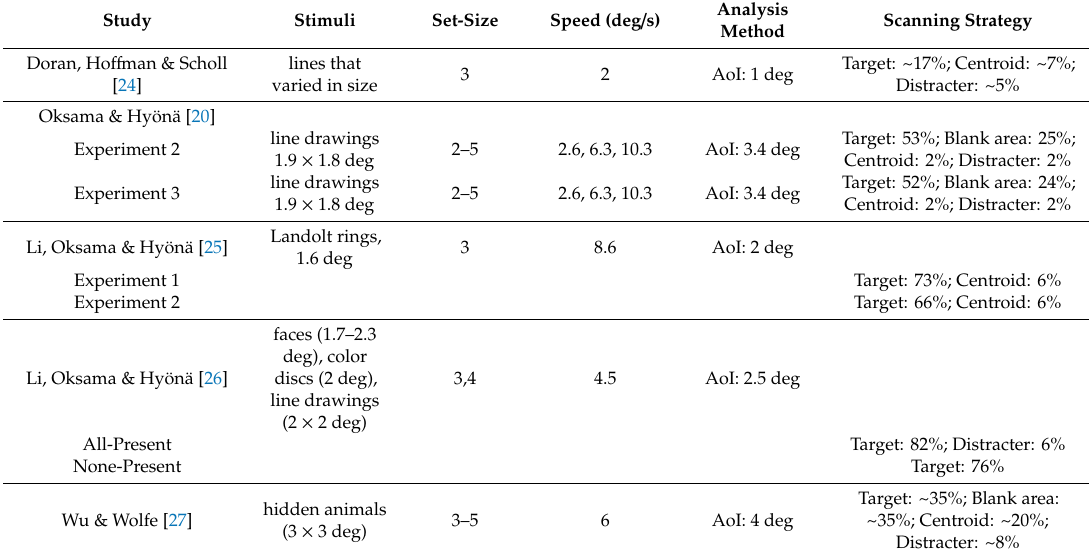
Table 2. Observed scanning strategies in eye-tracking studies of multiple identity tracking